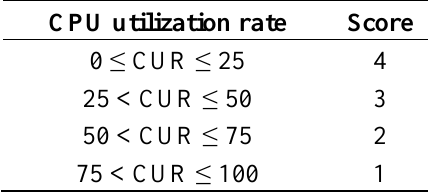
Table 5. The score table of CPU utilization